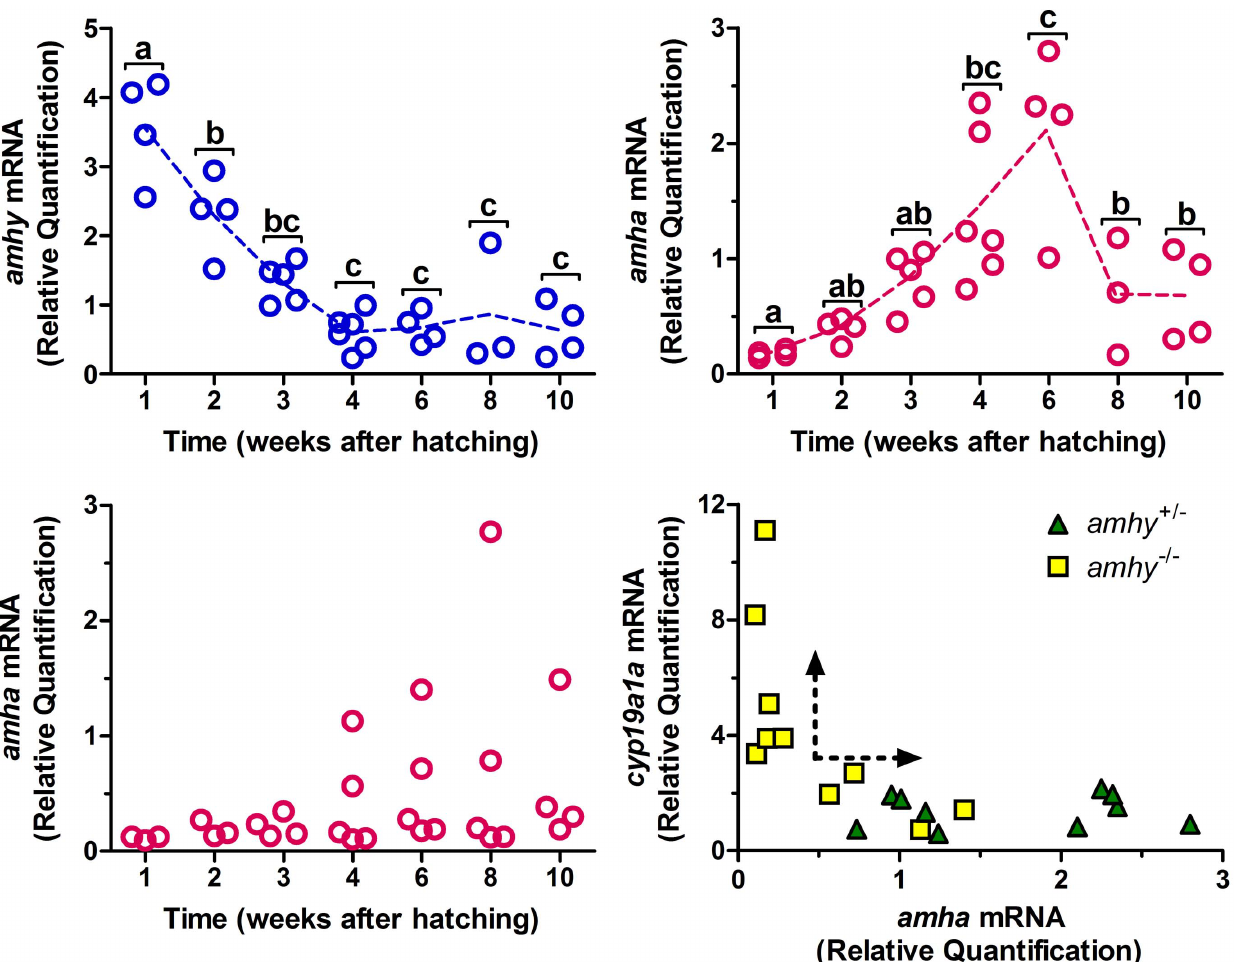
Figure 3. Quantification of amhy , amha and cyp19a1a mRNAs during sex differentiation. A to C : Abundance of mRNA transcripts of amhy (A) and amha (B) in amhy + / 2 genotypes and of amha in amhy 2 / 2 genotypes (C) during larval development at 25 u C (n=3 to 6 per time point; qRT- PCR). D : Abundance of amha mRNA transcripts in relation to cyp19a1a in amhy + / 2 and amhy 2 / 2 genotypes at 4 and 6 weeks after hatching (qRT- PCR); arrows indicate two arbitrarily-defined, opposing patterns of gene expression. b -actin was used as endogenous control. Values with different letters are statistically different from one another (One-Way ANOVA with Bonferroni’s post-test, p , 0.05).